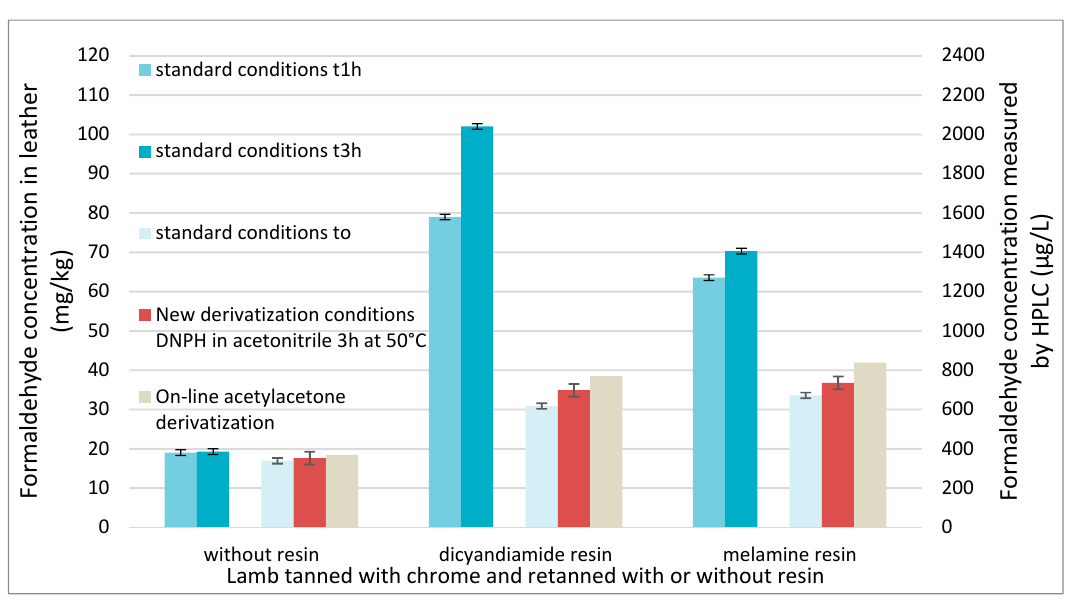
Figure 7. Comparison of three derivatization methods to determine formaldehyde in leathers: EN ISO 17226-1 standard conditions directly after the beginning of the derivatization reaction (in light blue), derivatization with DNPH in acetonitrile 3 h in a water bath at 50 °C (red) and acetylacetone derivatization with an online montage (in beige). For the standard conditions, the formaldehyde concentration analyzed during the time laps of the standard: in blue for 1 h and in dark blue for 3 h after the beginning of the derivatization reaction. Uncertainties given as two standard deviations (calculated with three measurements: three independent derivatizations).